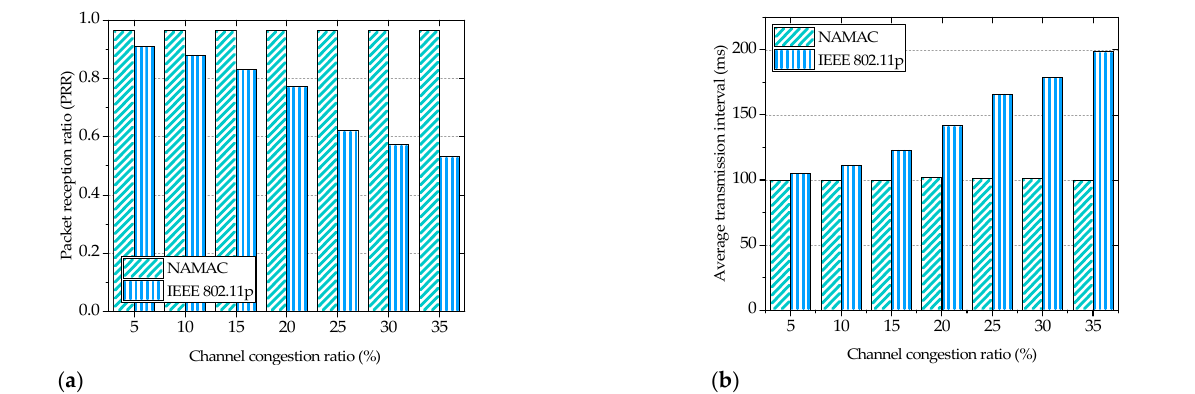
Figure 10. Experiment results: ( a ) packet reception ratio (PRR) under different channel congestion ratio (CCR) levels; ( b ) average transmission interval under different CCR levels.6.2. Measurement Results .